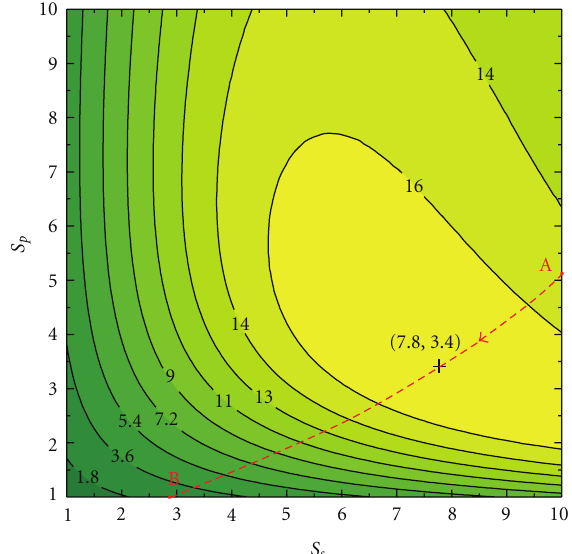
Figure 2: Contour plots ofsignalgain (indB) for an 8mmlongSRA in the plane formed by the factors S s and S p varying in the range 1 to 10. The location marked by + corresponds to the peak gain of 17.7dB. Here, I p 0 = 30MW / cm 2 , I s 0 = 0 . 1MW / cm 2 , α = 1dB / cm, and τ c = 0 . 2ns. Other parameters are the same as in Figure 1. The red curve shows how the gain peak’s position drifts as I p 0 changes from 15MW / cm 2 at point A (10, 5 . 13) to 300MW / cm 2 at point B (2 . 9,1).